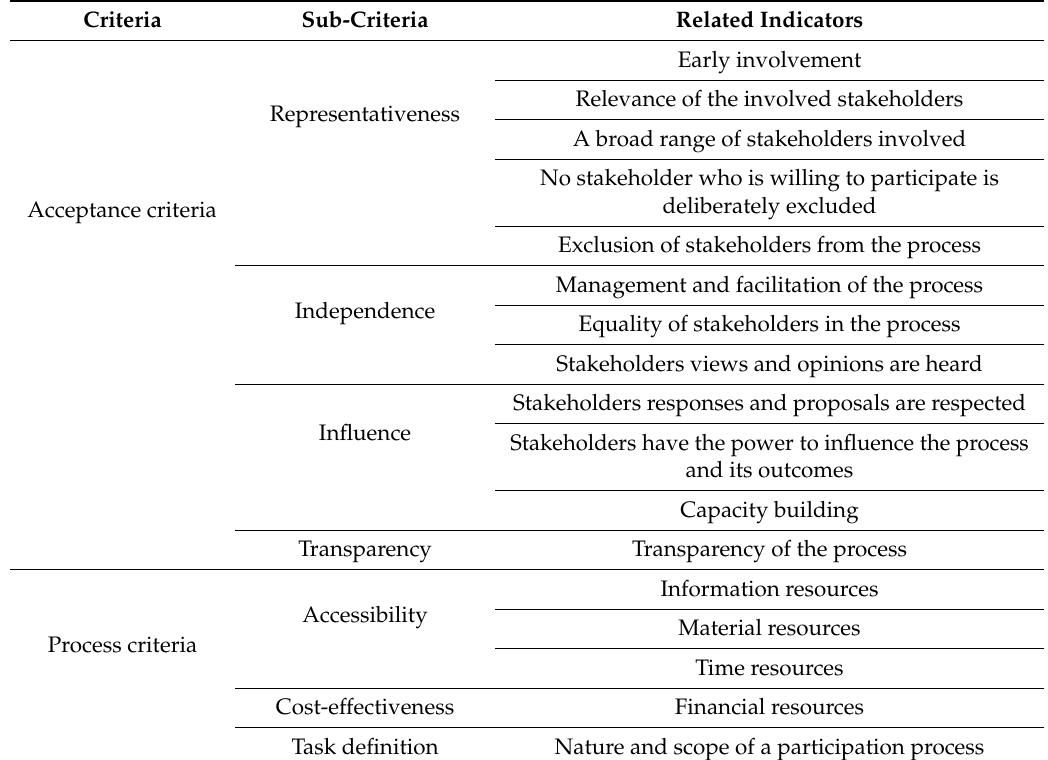
Table 1. Evaluation Criteria and Indicators for an Effective Participatory